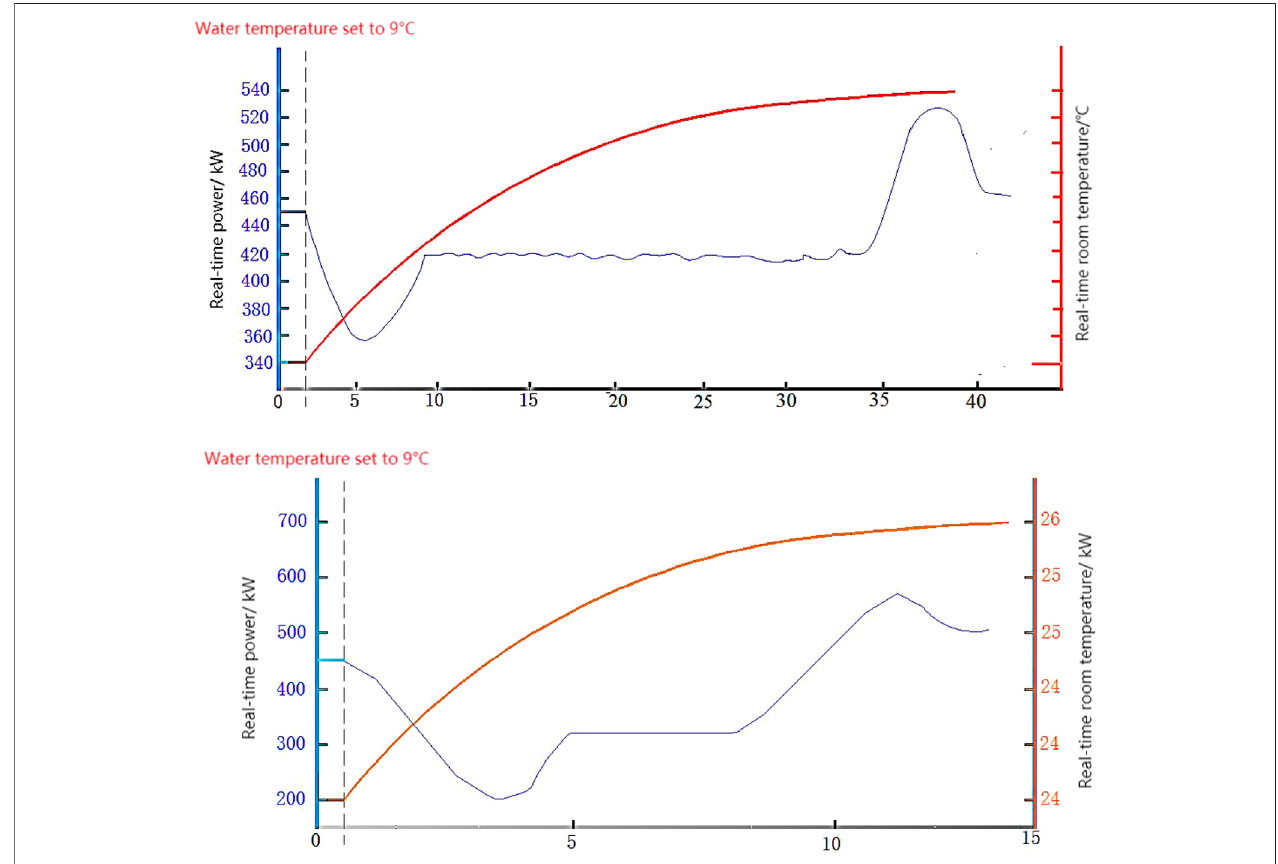
FIGURE 7 | Power and return air temperature under T chilled going to 9 ° C and 12 ° C.